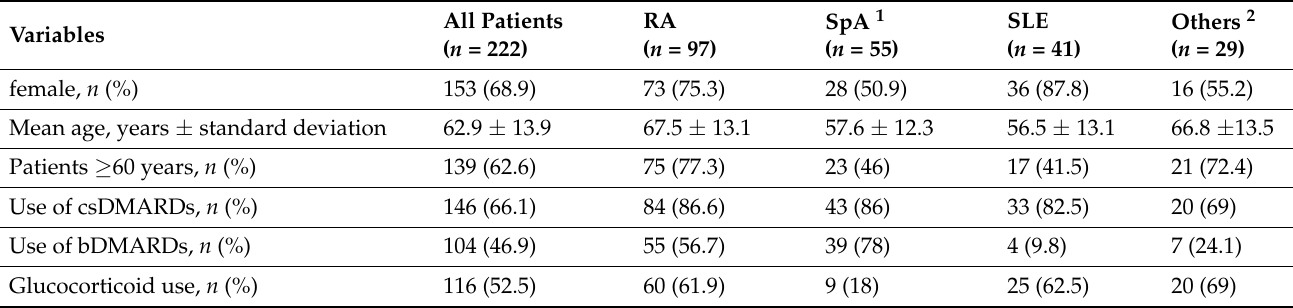
Table 1. Clinical characteristics of the included